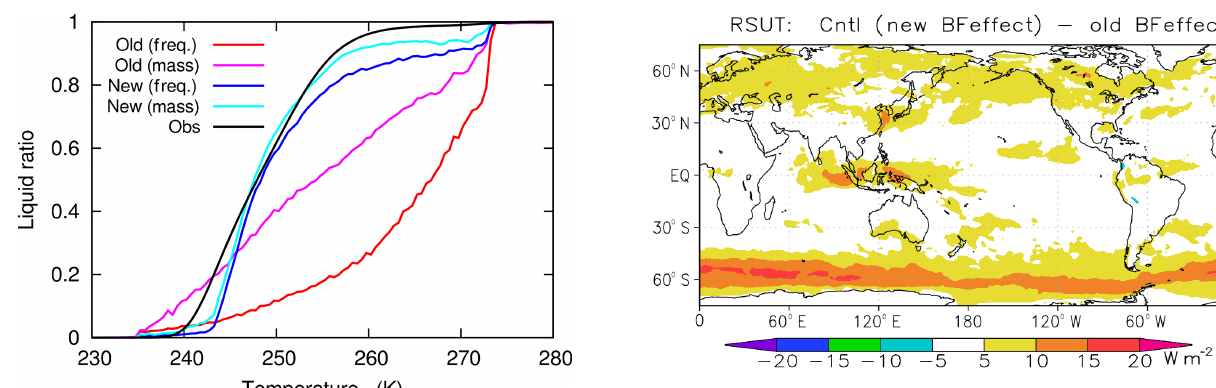
Figure 5. Impact of the new treatment of the WBF effect on TOA upward shortwave radiative flux (Wm − 2 ) . The plot shows the re- sults for the control model (with the new treatment) minus those for an experiment with an old version of the